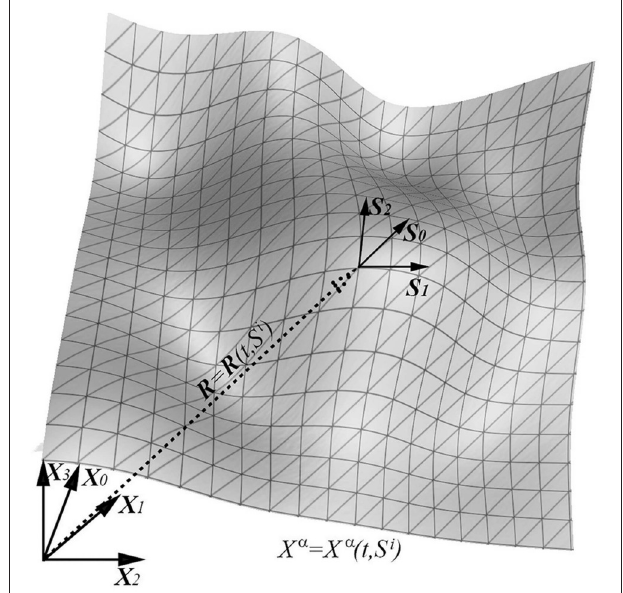
FIGURE 1 | Two dimensional illustration of a curved three dimensional surface embedded in Minkowski space-time. X α represents the analog of Cartesian coordinates of Minkowski space-time. S i are base vectors defined in tangent X α ( t , S i ) is the general equation of the space and X α =